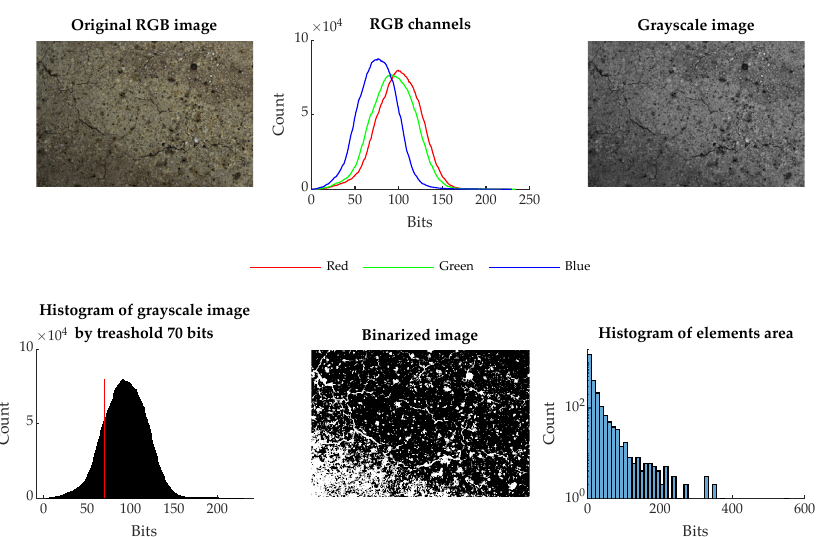
Figure 14. The process of image feature BW ratio I R for specimen degraded at 1200 °C. However, this comparison is sufficient to differentiate the individual test sets, as can be seen in Figure 16, where the x-axis shows the dominant frequency F L , the y-axis the signal attenuation, and the z-axis the average value of the green channel of the macrotexture photo. Here, one can clearly distinguish all the test sets that occupy a specific place in the NDT measured parameters. The machine learning algorithm can be used to